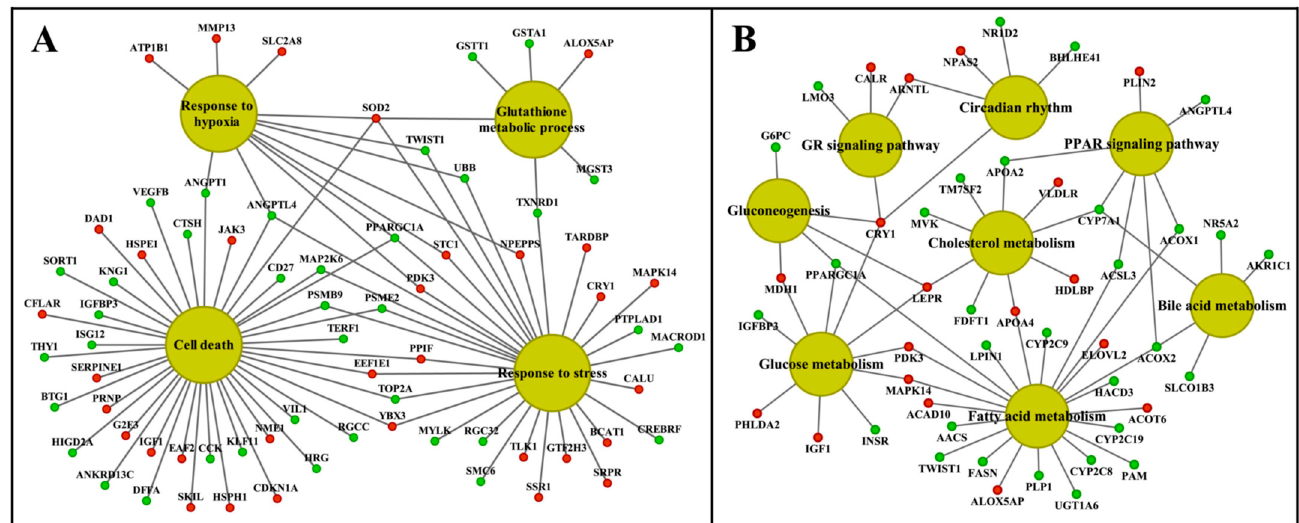
Figure 8. Gene ontology and pathway mapping network of liver-regulated genes in response to high-dose diclofenac treatment. The enriched biological processes and pathways of high-dose-treated animals were computed with the ClueGO and the GeneXplain software and visualized using the Cytoscape software version 3.9. Panel A : Stress and cell-death-associated gene network. Panel B : A network of genes enriched in circadian rhythm and metabolic processes. The red and green color nodes define induced and repressed transcript expression, respectively.